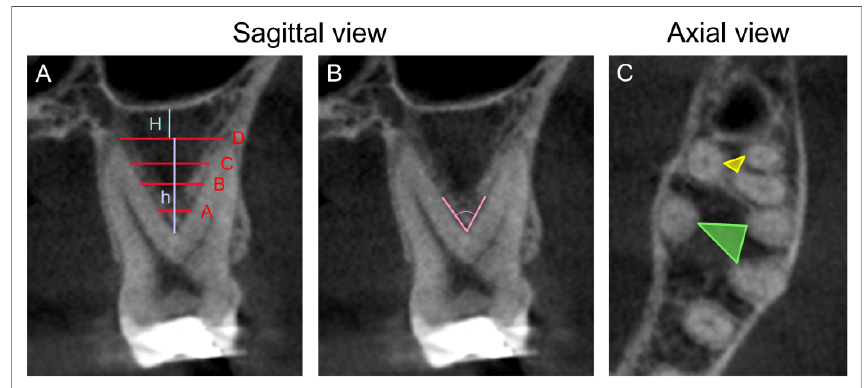
Figure 1. CBCT scans and landmarks of interest. ( A )—Sagittal view: the interradicular septum width at level A (at 2 mm distance from furcation), B (at the mid length of h), C (at 2 mm distance from the interradicular septum base), and D (at the interradicular septum base); the interradicular septum height—h; the distance between the interradicular septum base and the sinus floor—H. ( B )—Sagittal view: the interradicular furcation angle. ( C )—Axial view: the interradicular septum surface perimeter and the surface area (for the first molars—green, and the second molars—yellow line). The analysis of the obtained parameters was performed according to the following algorithm (Figure